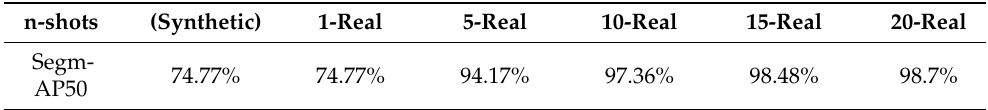
Table 7. Segm-AP50 results comparing purely-synthetic training with few-shot fine-tuning against the controlled dataset {5} .